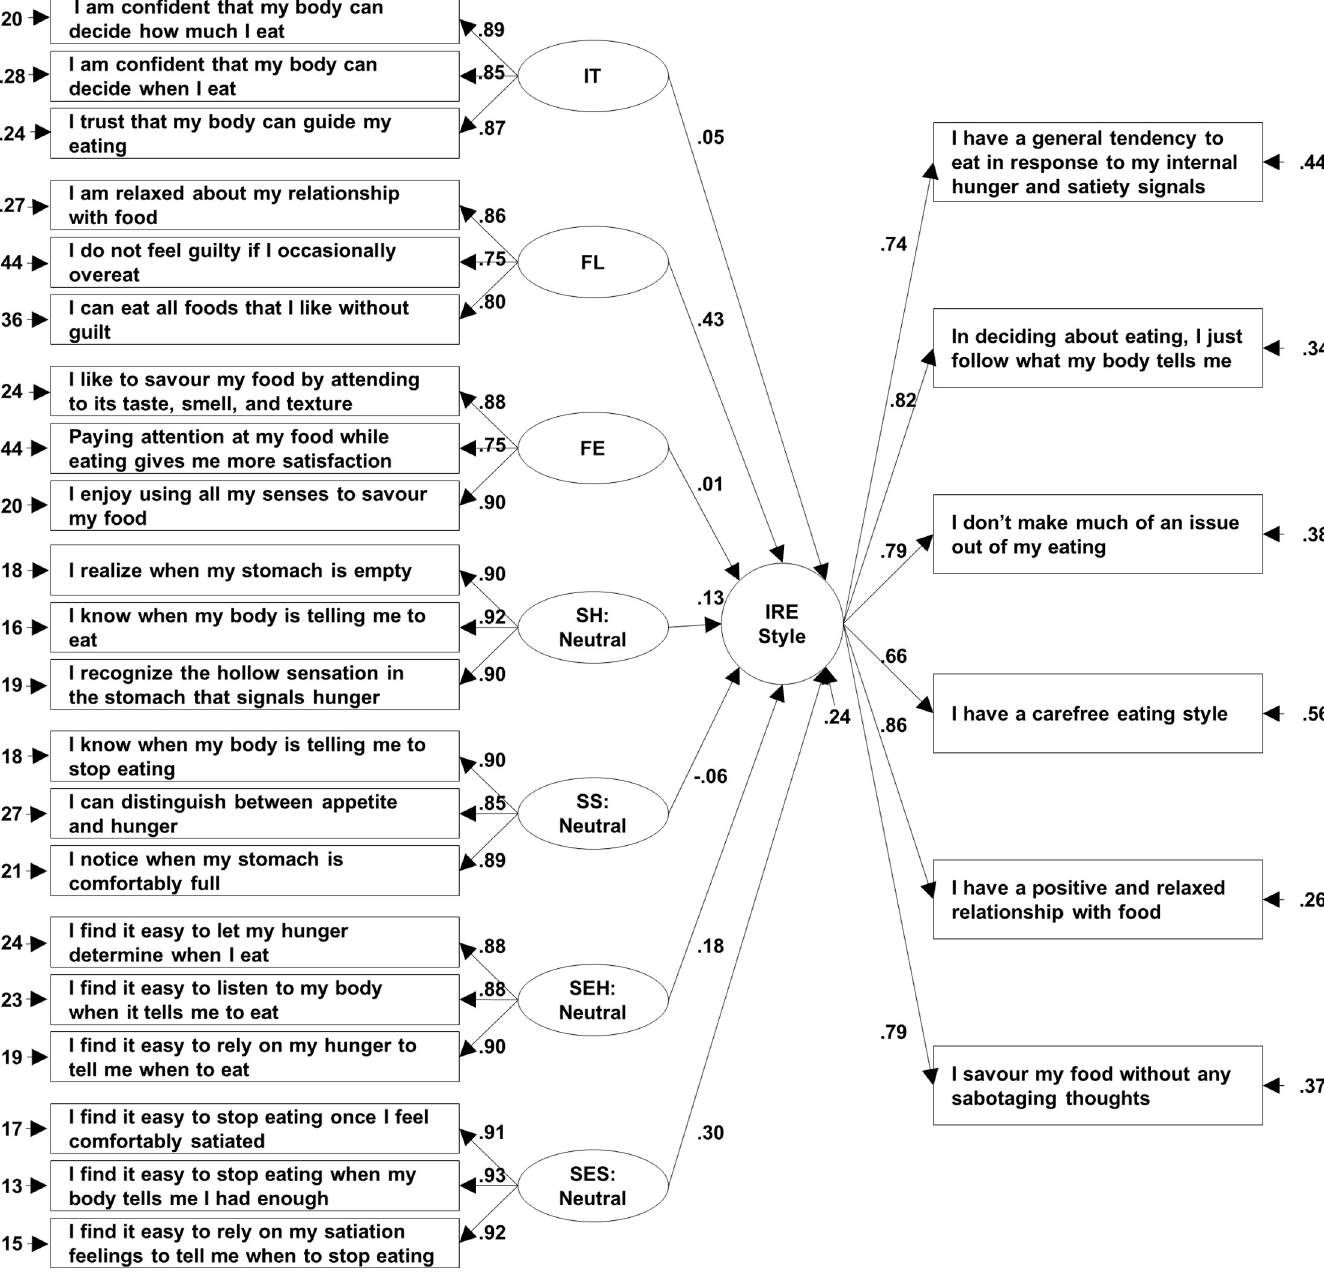
Fig 2. The multi-dimensional model of internally regulated eating style (simplified version). All loadings were significant at the 0.01 level. Covariances and disturbance terms of first-order factors are not depicted in the figure for easier readability. Using a bottom-up approach, we showed that all first- and second-order factors of MIRES are measured reliably and a significant amount of variance in the items is accounted for by the corresponding latent factors. All first-order models and the multi-factor model that we tested had very good fit to the data. We confirmed that sensitivity to hunger, sensitivity to satiation, self-efficacy with hunger, and self-efficacy with satiation are distinct constructs, and that the